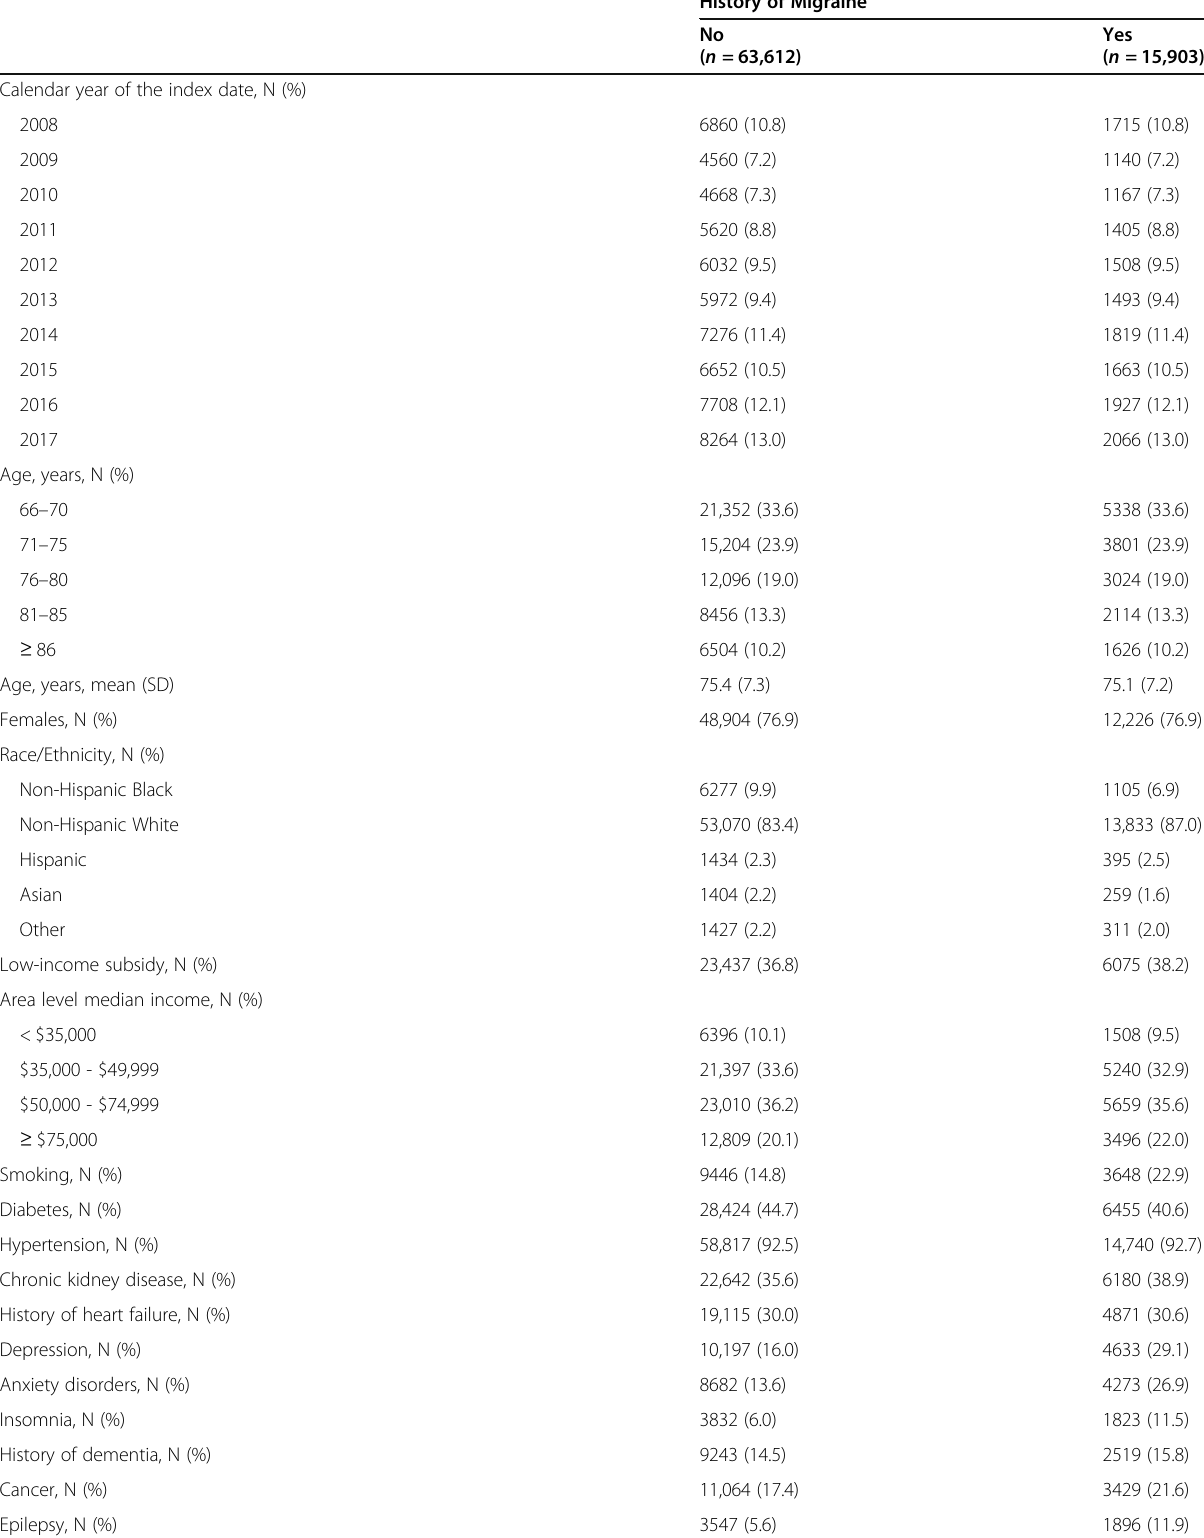
Table 3 Characteristics of patients with a history of cardiovascular disease who had and did not have a history of